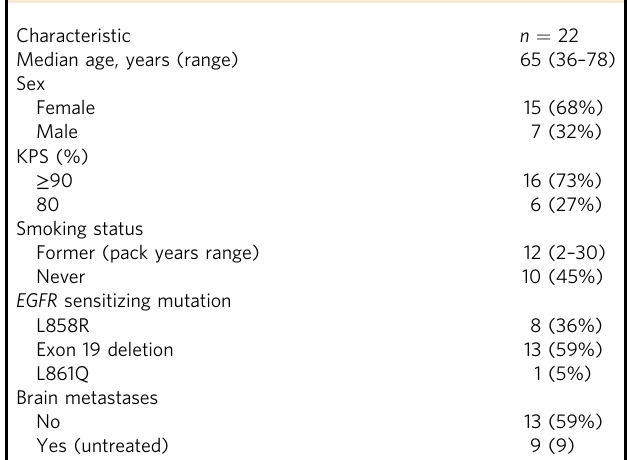
Table 2 Baseline patient